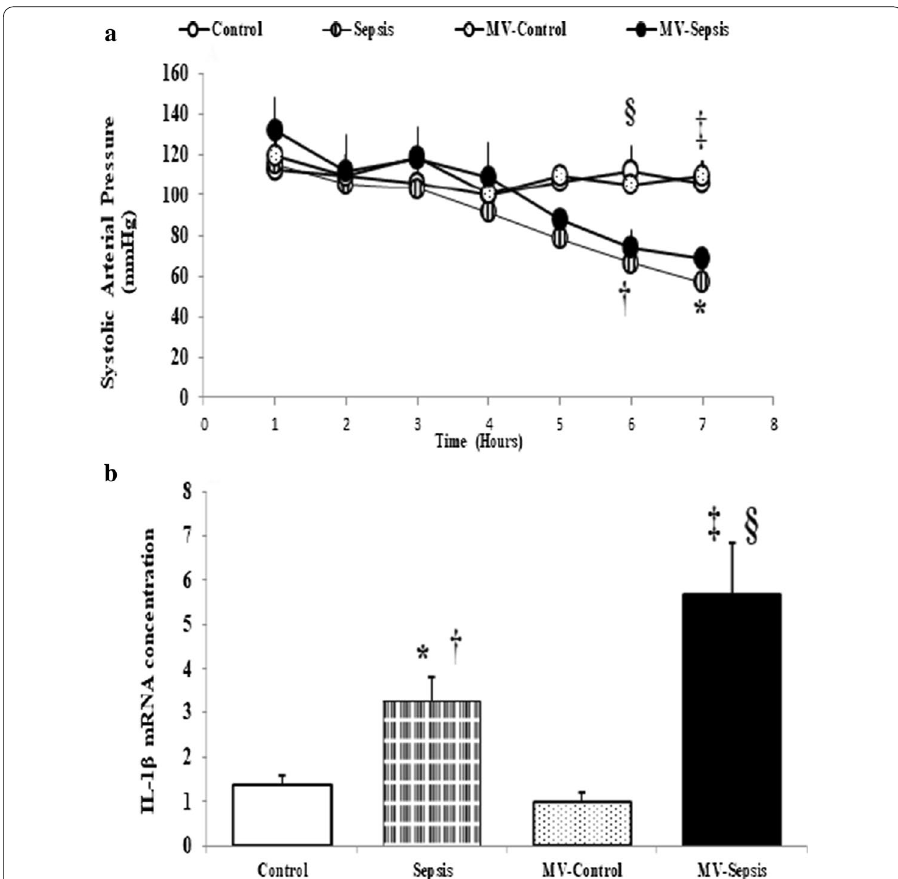
Fig. 1 Effects of cecal ligation and puncture protocol and mechanical ventilation on arterial blood pressure, cytokines, and mRNA levels. Rats underwent cecal ligation and puncture (CLP) ( n 12) at time 0. Animals were resuscitated with normal saline (10 ml.kg − 1 .h) intravenously. Half of the CLP = and sham rats were intubated and mechanically ventilated and assigned to one of four groups ( n group): (1) a spontaneously breathing control group (control), (2) a spontaneously breathing septic group (sepsis), (3) a mechanically ventilated control group (MV‑control), and (4) a mechanically ventilated septic group (MV‑sepsis). a Shows the mean arterial blood pressure (MAP mmHg) throughout the study in control groups (open circles) and sepsis groups (dark circles). Data are means * p < 0.05 sepsis versus control; ‡ < 0.05 MV‑sepsis versus control; † p < 0.05 sepsis versus MV‑control; § p < 0.05 MV‑sepsis versus MV‑control. Panel B shows diaphragm interleukin 1 beta (IL‑1β) mRNA expression ( b ). Transcript levels of each group were standardized with mRNA level of 18 S. Data are means animals per group. * p < 0.05 sepsis versus control; ‡ < 0.05 MV‑sepsis versus control; † p < 0.05 sepsis versus MV‑control; § p < 0.05 MV‑sepsis versus MV‑control for 4 animals per group